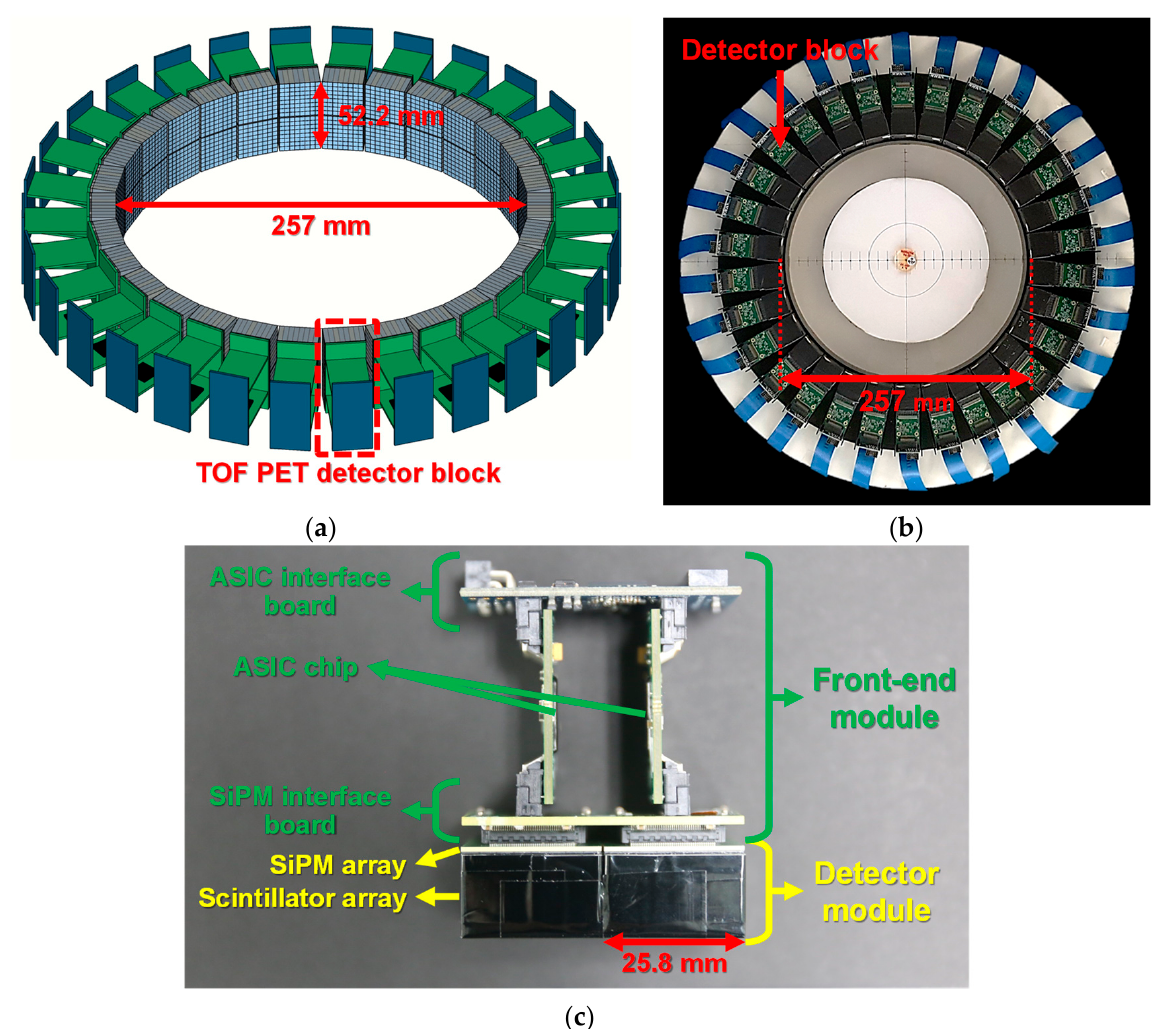
Figure 1. ( a ) Geometry of the proposed TOF brain PET. ( b ) Photograph of the developed TOF brain PET consisting of 30 detector blocks connected to flexible flat cables. ( c ) Configuration of the TOF PET detector block.